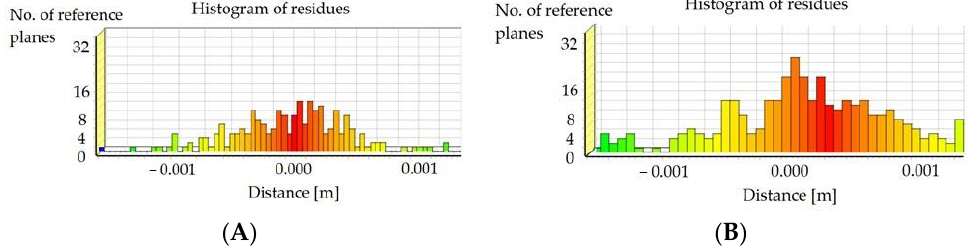
Figure 13. Results of scan position alignment between ( A ) reference and S1 and ( B ) reference and S2.